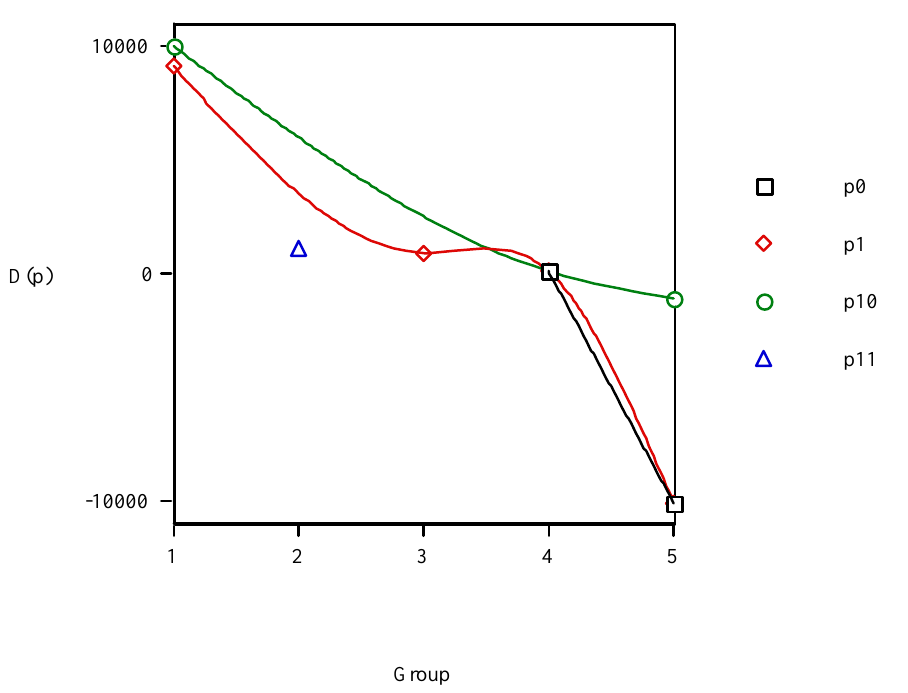
Figure 11. Variation of D ( p ) = P ( p +1) – P ( p ) vs . group number. P is the vector